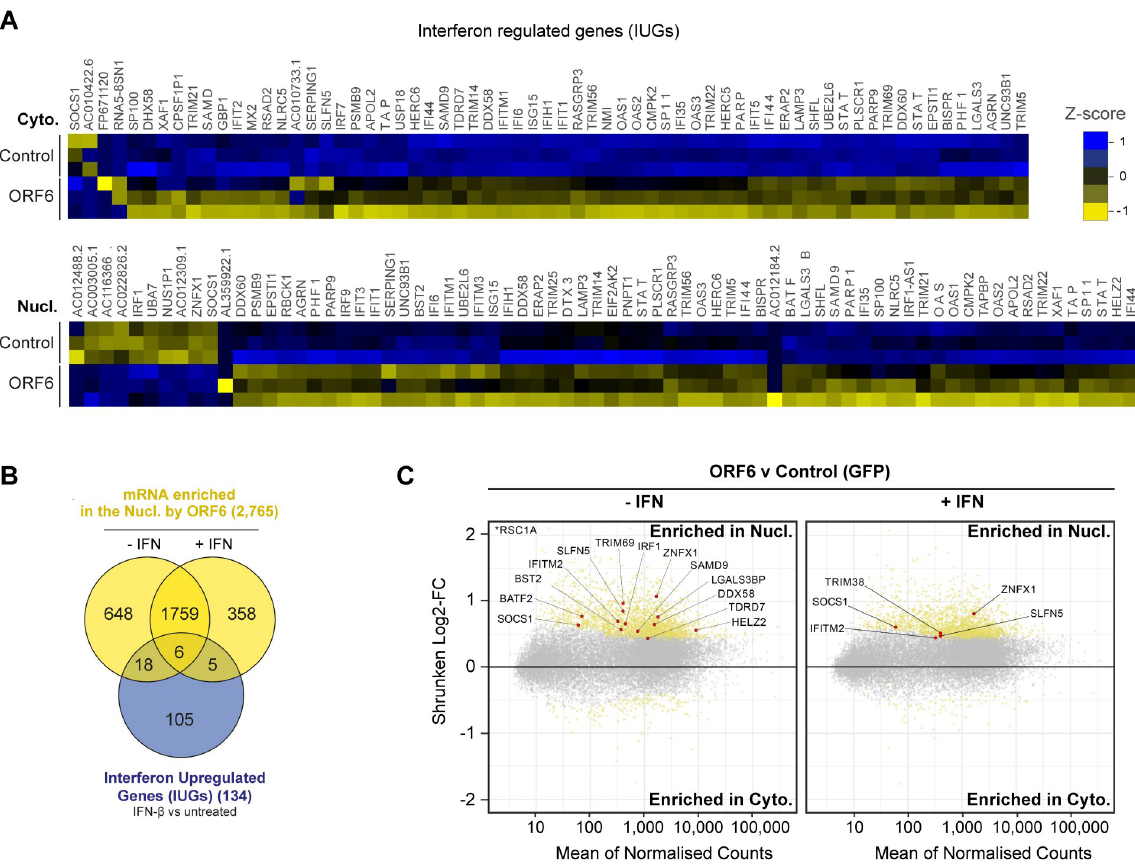
Fig 4. ORF6 inhibits the nuclear export of IFN-upregulated mRNA. (A) Interferon upregulated genes (IUGs) were identified as mRNAs that were significantly upregulated after IFN treatment compared to untreated cells (see S5A Fig). These IUGs were then compared to the list of mRNAs that were significantly upregulated or downregulated by ORF6 compared to the GFP control (see S5E Fig), in either the Cyto (upper panel) or Nucl (lower panel) fractions. The heat maps show the Z-score (scaled and centred per-gene expression) in IUG expression in cells expressing GFP (Control) or ORF6 after IFN treatment, for three biological repeats. (B) Venn diagram showing the number of IUG mRNAs that were significantly enriched in the nucleus by ORF6 with and without IFN treatment. (C) The log2-fold change (Log2-FC) in mRNA abundance was calculated between the Nucl and Cyto fractions for both GFP and ORF6 expressing cells, without and with IFN treatment, as in Fig 3B, to determine which mRNA were specifically enriched by ORF6. The log-2FC was weighted against the adjusted p -value (shrunken Log2-FC) to show significantly enriched mRNA (yellow points). IUGs are highlighted in red and